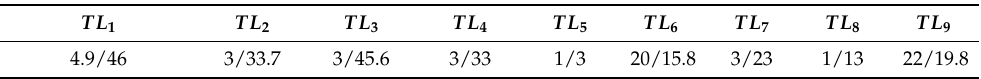
Figure 3. Proposed configuration of the RF-to-DC rectifier ( a ) Greinacher voltage-doubler design and ( b ) Impedance matching network design. Table 4. Optimal physical parameters of the transmission lines included in the proposed impedance matching network as illustrated in Figure 3b (each set of values for every physical parameter is denoted as width/length and is expressed in